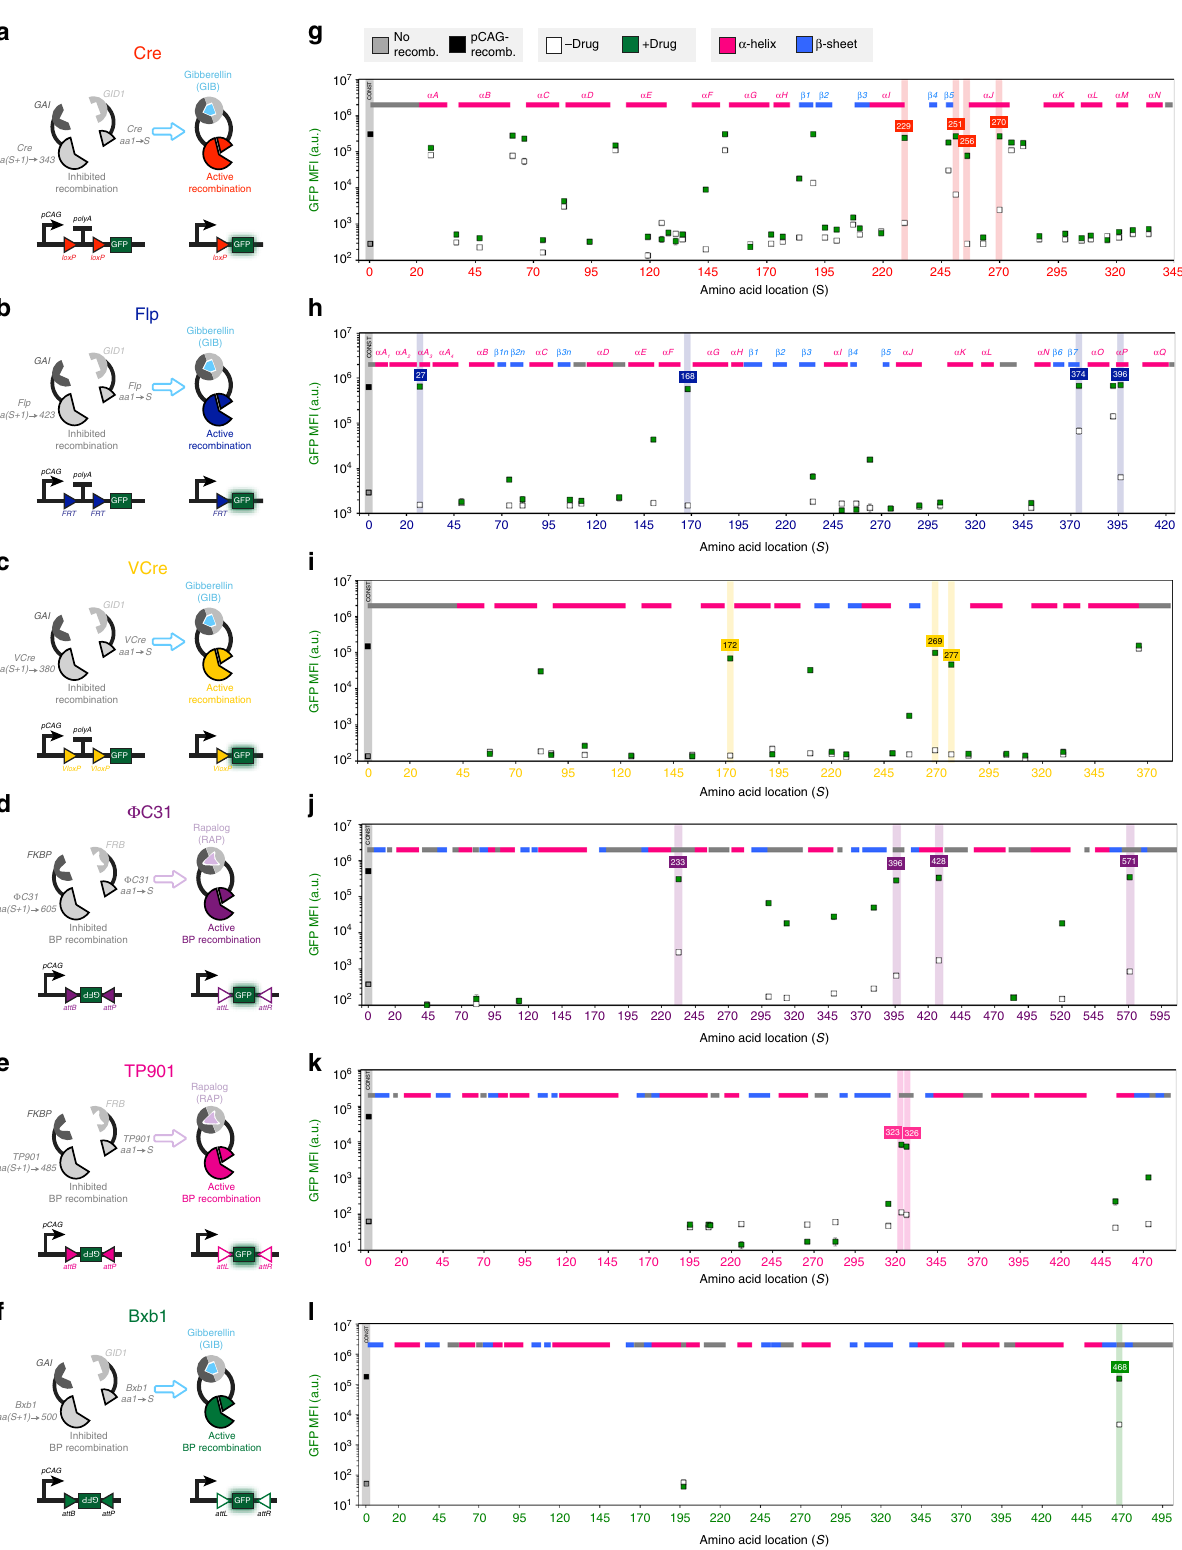
–Drug +Drug α -helix β -sheetNo recomb. pCAG-